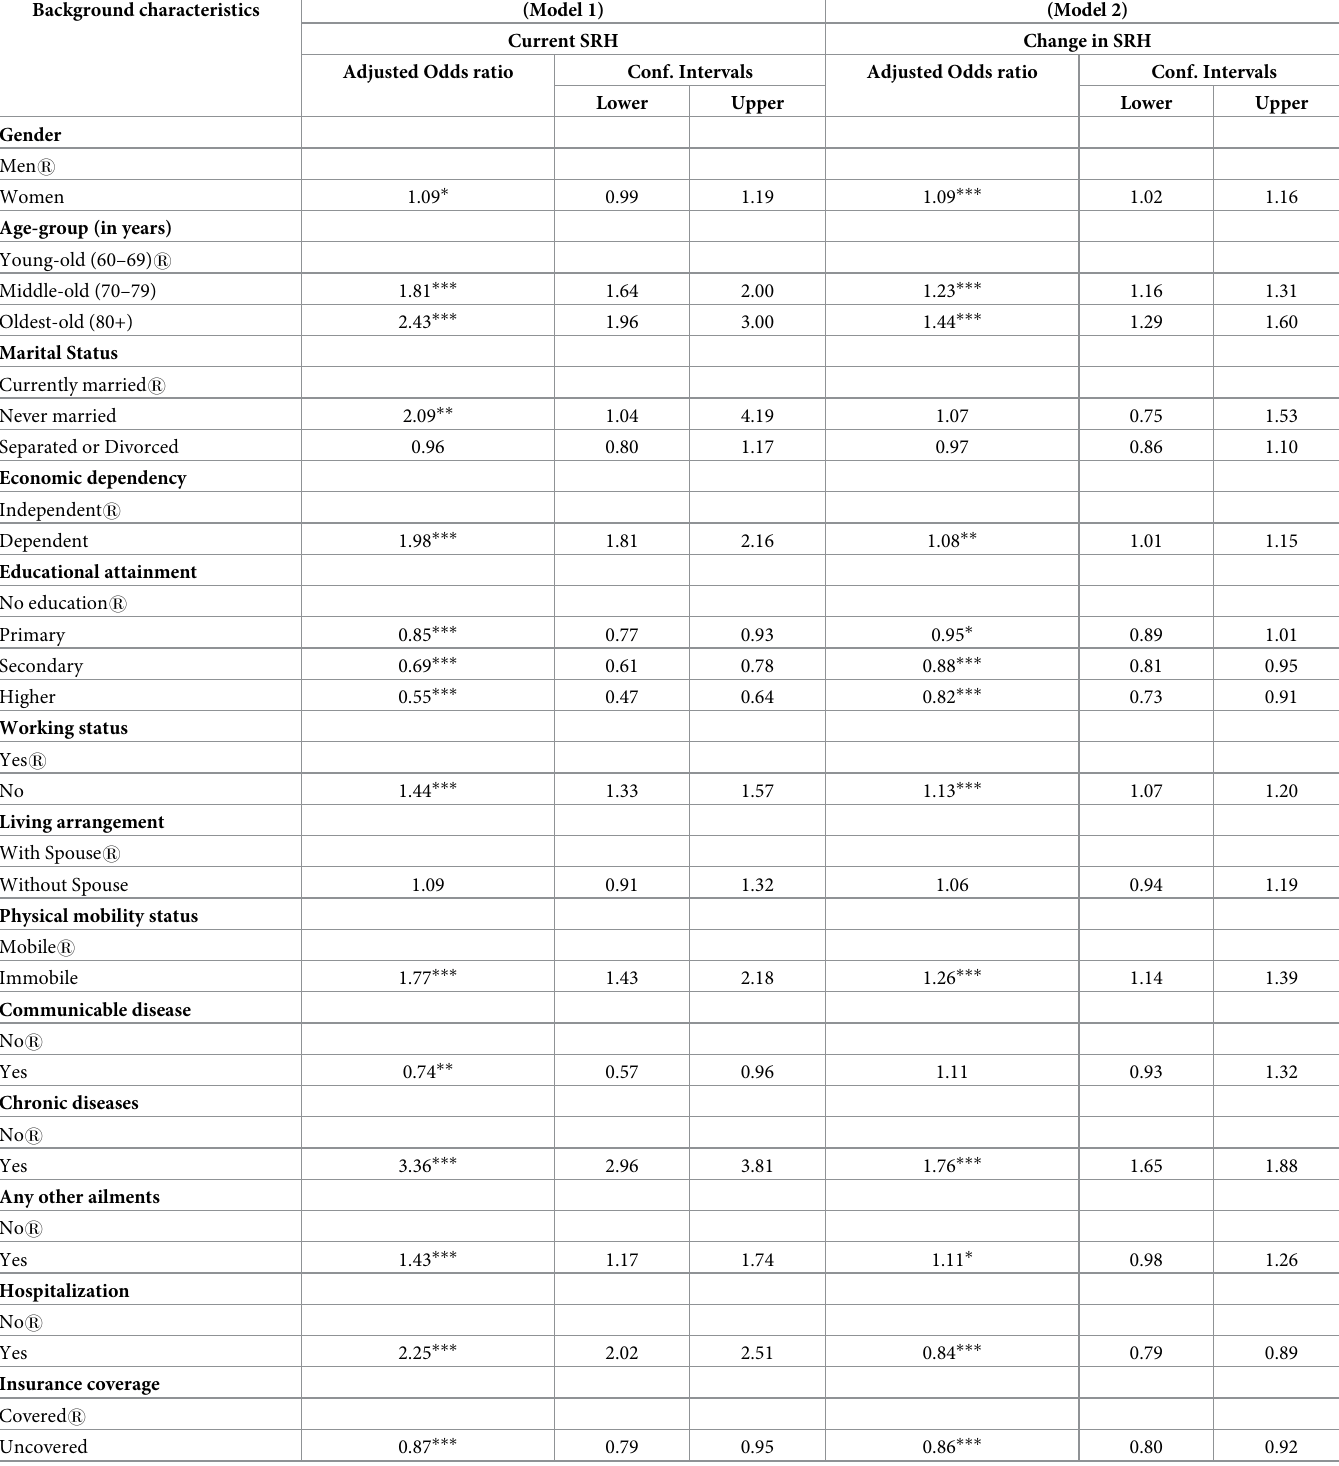
Table 4. Binary logistic regression results for current and change in self-rated health among older adults in India by gender with suitable background characteris- tics, 2017–18. (n =